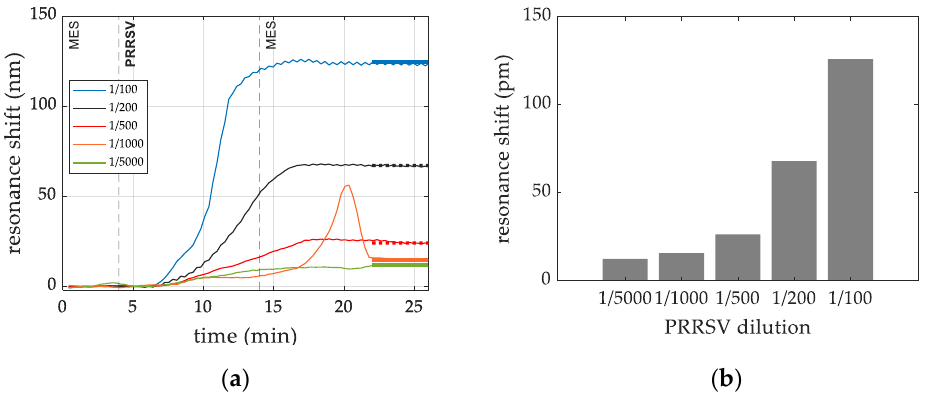
Figure 7. ( a ) Dose dependence signal shift (measured in pm) for pAb (alpha diagnostic) for each PRRSV dilution factor. The peak observed at minute 20 for the (1/1000) dilution involves a RI increase. It is ascribed to fluidic instabilities in the fluidic chamber, where the two solutions are being exchanged, giving rise to an increase of the refractive index [17]. ( b ) The detection levels for each dilution tested are summarized in a bar